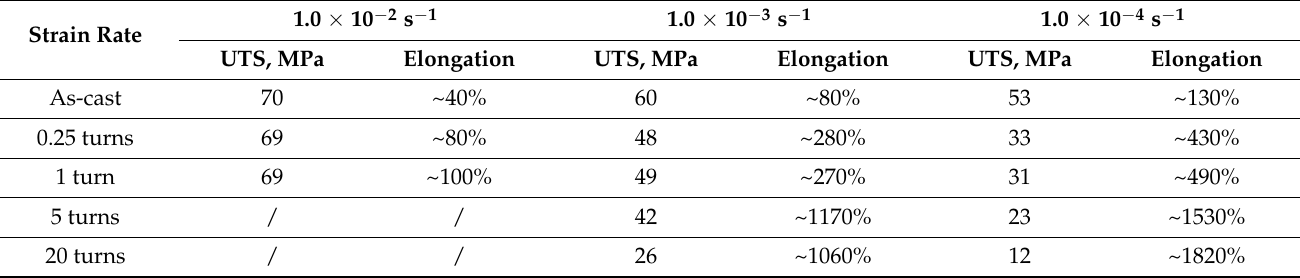
Table 1. Tensile properties of the Bi–Sn samples under various initial strain rates at RT. Strain